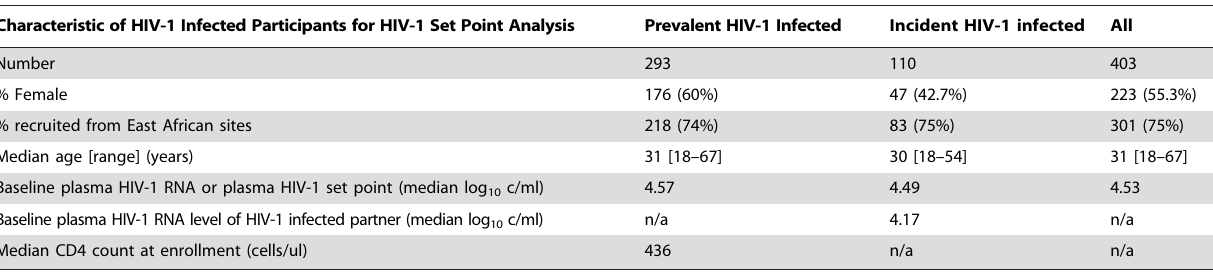
Characteristic of HIV-1 Infected Participants for HIV-1 Set Point Analysis